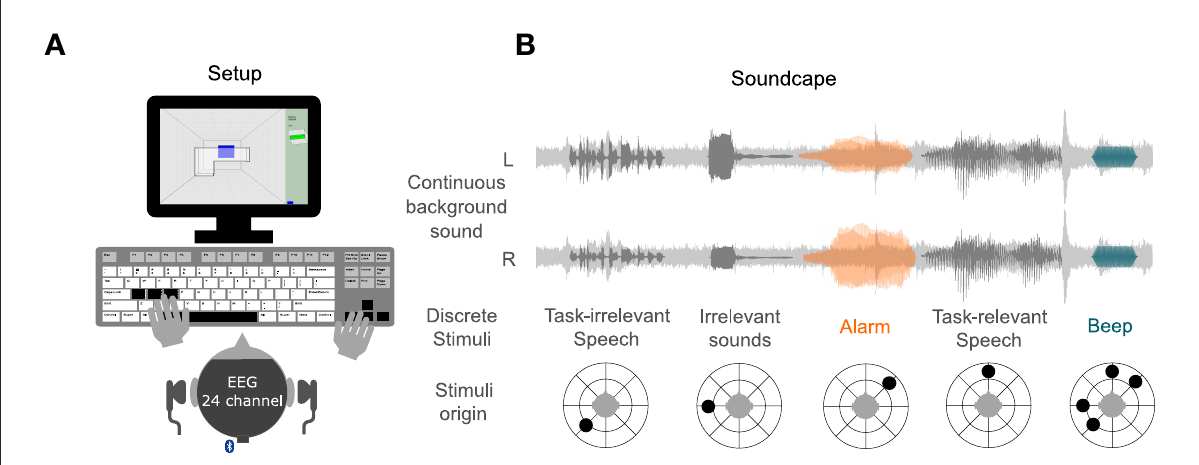
FIGURE1 (A) Experimental Setup: Participants played 3D Tetris (with their left hand the participant controlled the rotation of a block, with their right hand the position of a block). The soundscape was presented via headphones. EEG was recorded using a 24-channel mobile EEG setup. (B) Soundscape: A continuous background sound was presented throughout the task. Discrete stimuli were subsequently presented. The alarm was the target in the narrow condition, while the beep was the target in the wide condition. The alarm was presented from one direction, while the beep was presented from any direction as the other sounds. If participants detected a target, they should press the space